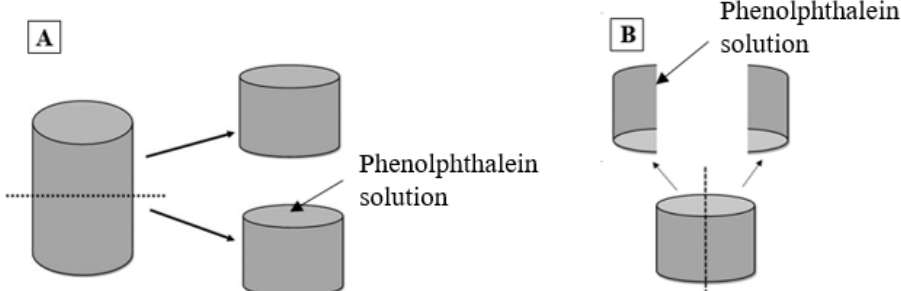
Figure 2. Cutting pattern of samples for measuring carbonated thickness after spraying phenolphthalein solution: transversal cut (A) and longitudinal